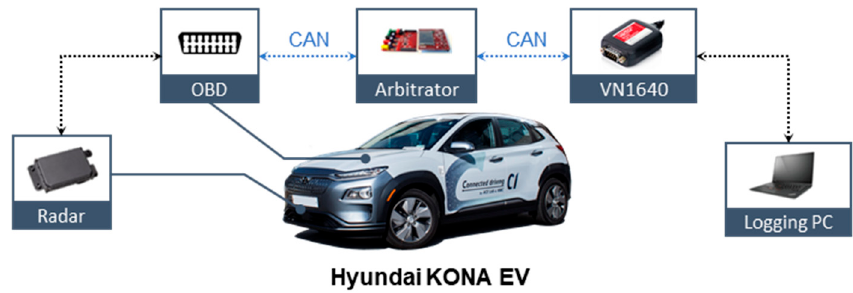
Figure 3. Vehicle Figure 3. Vehicle configuration.